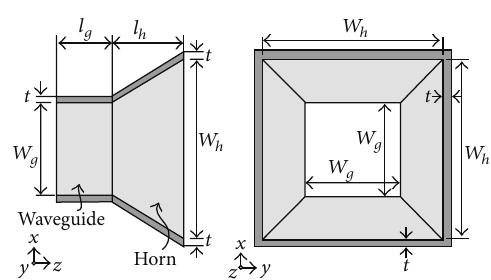
waveguide part of the horn is integrated on FR4 substrate.